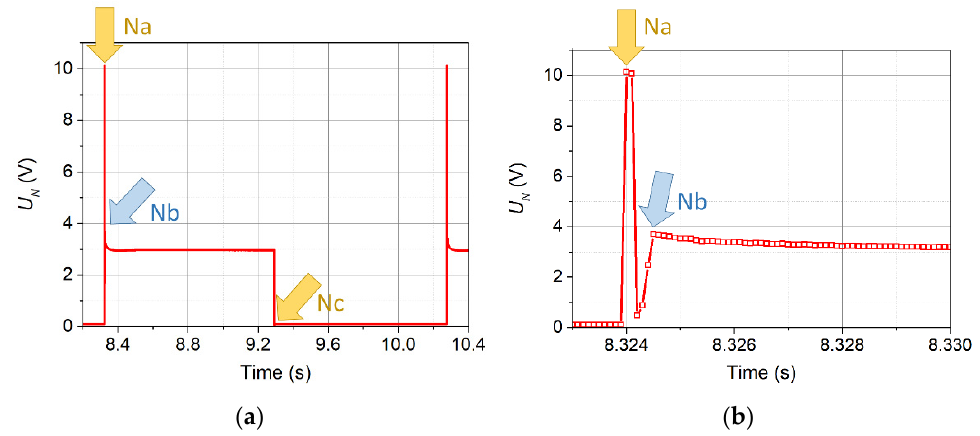
Figure 8. Selected characteristic points of the voltage signal provided at the transmitter ( a ). Precise position of point Nb ( b ).